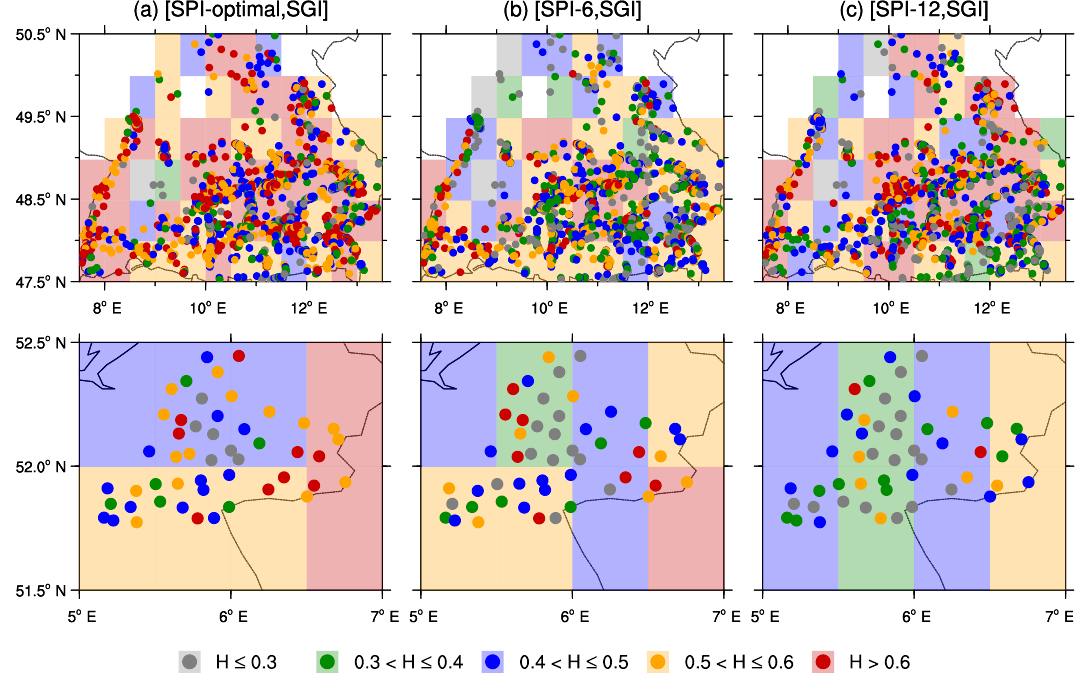
Figure 6. The hit rate ( H ) to detect SGI-based groundwater droughts using the SPI with the (a) optimal accumulation period and (b, c) 6 and 12 months of uniform accumulation periods at the point and gridded scales for German (top) and Dutch (bottom) data sets. A threshold value τ of 0.2 is used to identify drought events.